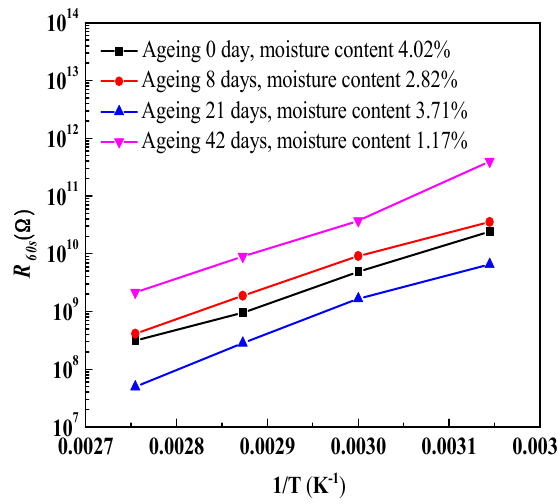
Figure 11. Variations of insulation resistance ( R 60s ) with the absolute temperature decrease.